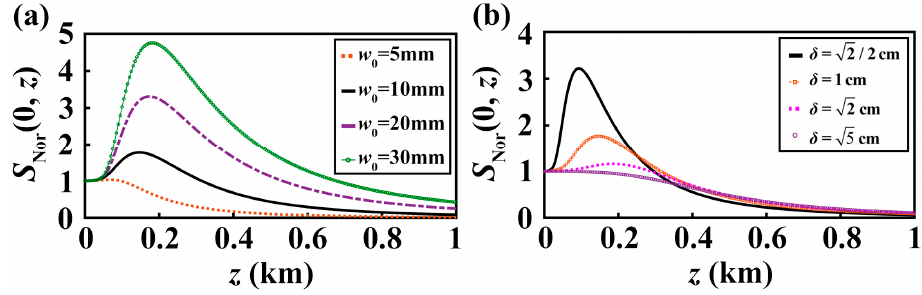
Figure 8. Normalized on-axis intensity of LNUC beams propagating in oceanic turbulence for different ( a ) beam widths and ( b ) coherence lengths.